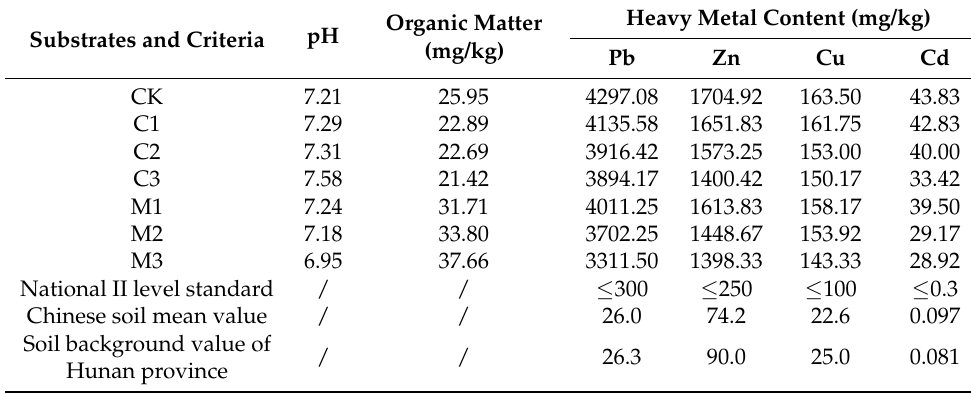
Table 2. Physical and chemical properties of soil used for pot test. Substrates and